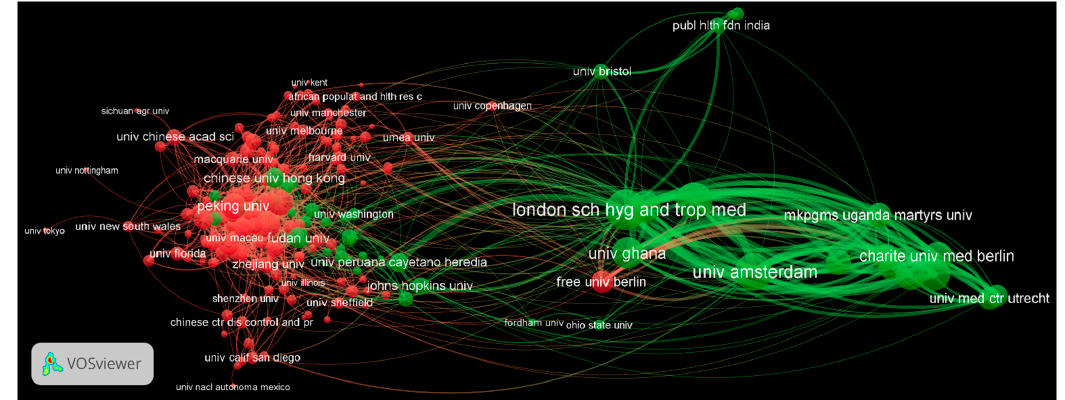
Figure 4. Network of institutional cooperation. Table 4. Top 10 institutions in the field of rural-to-urban migrants (1 January 2004–3 June 2022).